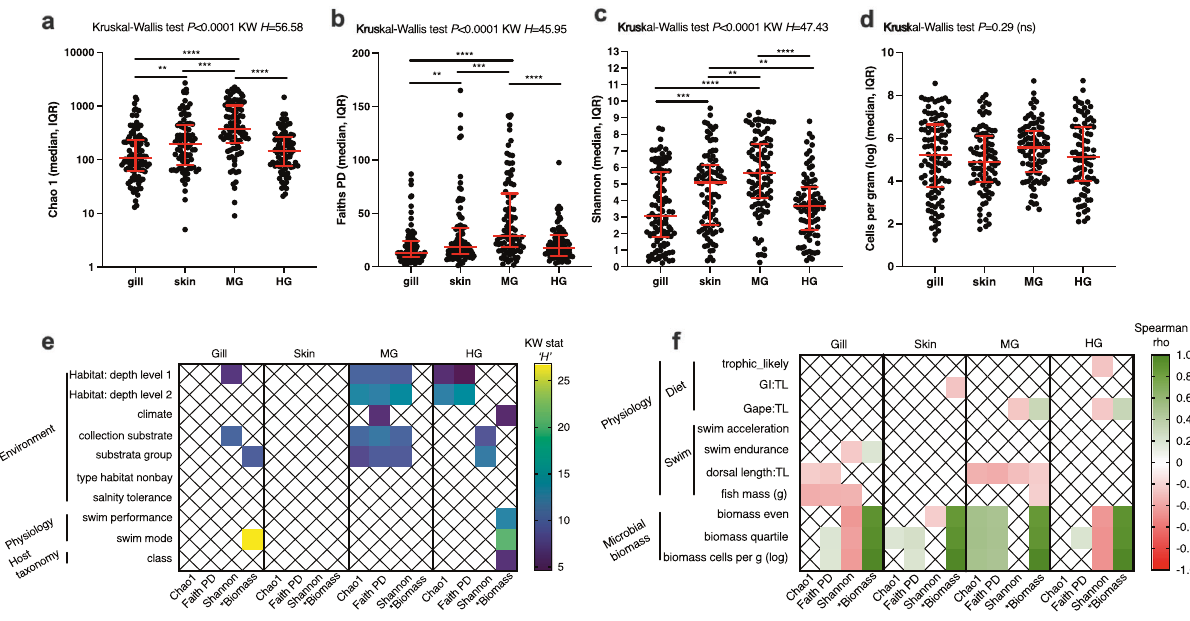
Fig. 3 | Alpha diversity and biomass comparisons across ecological and biolo- gical gradients in marine fi sh. Comparison of microbial diversity a “ Chao1 ” , b “ Faith ’ sPhylogeneticDiversity ” , c “ Shannon ” ,or d microbialbiomassacrossbody site (gill, skin, midgut, and hindgut). Distributions in “ red ” are median with inter- quartile range. Statistical differences determined using non-parametric testing Kruskal – Wallistestwith 0.05 FDR Benjamini – Hochberg. Further testing